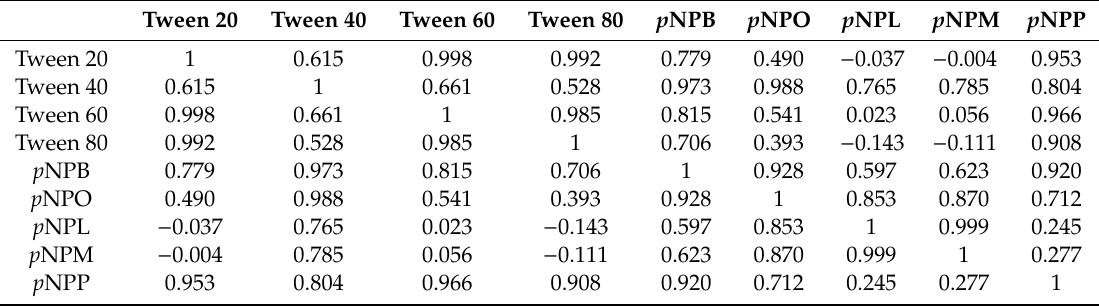
Table 2. Correlation matrix for the esterase and lipase activity data sets against p -nitrophenyl esters and Tweens, respectively.